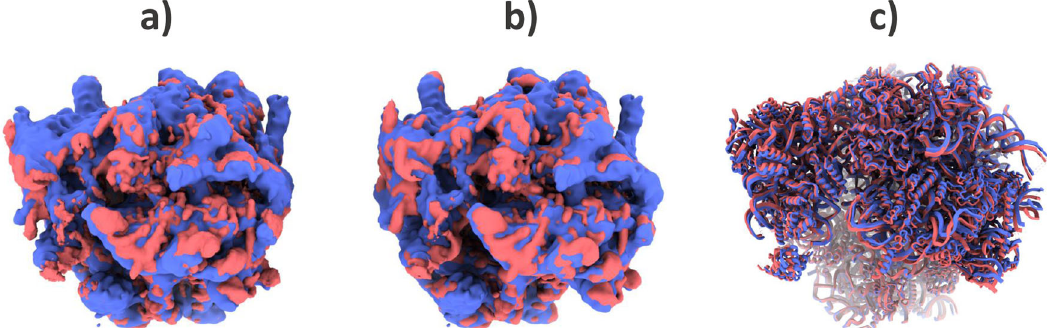
Fig. 2 | Example of Pf80S Zernike3D states. a Comparison of the reference con- formation required by the Zernike3D algorithm (red) and the rotated Pf80S state recovered from a homogeneous re fi nement with CryoSparc (blue). b Comparison of the rotated Pf80S state recovered from the Zernike3D deformation fi elds (red) and the rotated Pf80S state recovered from a homogeneous re fi nement with CryoSparc (blue). The particles processed by CryoSparc are taken from the coef- fi cient space area de fi ned by the orange dot in Fig. 1, and the deformation fi eld is computed with the coef fi cients associated with this dot. The comparison between